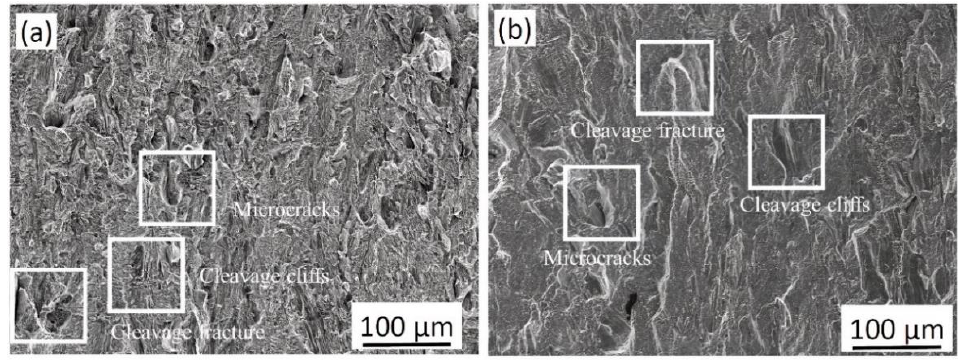
Figure 5. The fracture surface of ( a ) −196 °C specimen 3 and ( b ) −196 °C specimen 4, indicating quasi-brittle fracture characteristics.